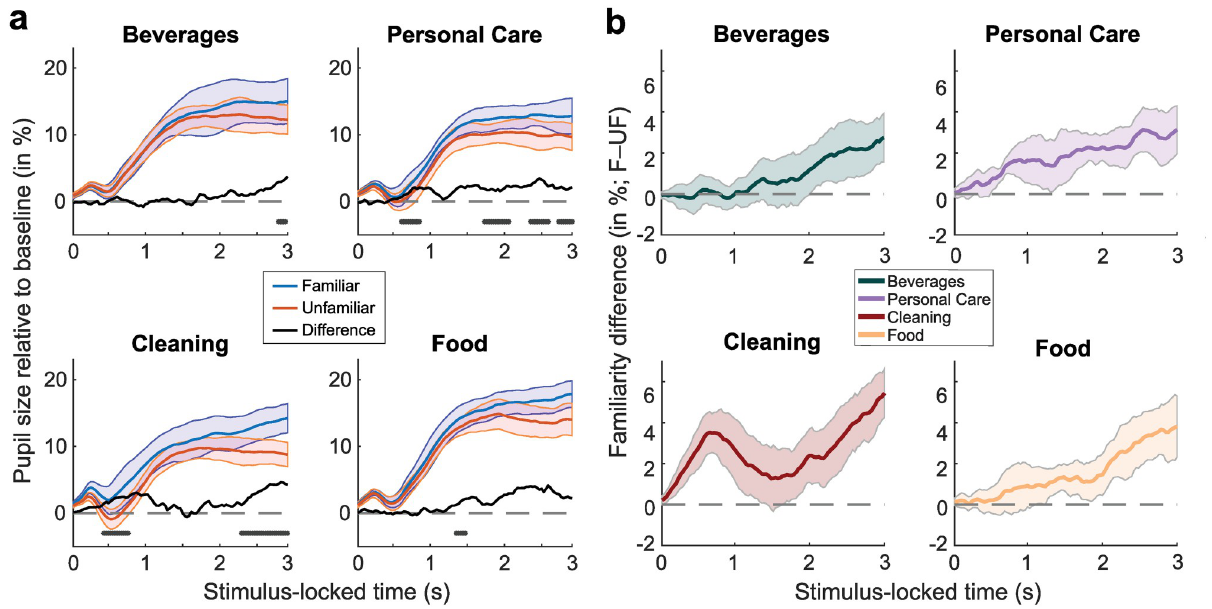
Fig 3. Product category-based pupil size change relative to baseline and individual dynamic range. a) Comparison of pupil responses to both familiar (blue) and unfamiliar (orange) intact branded images over time. Colorful lines show the group mean and shaded areas the bootstrapped standard errors of the mean for each condition. As a result of the temporal cluster-based bootstrapping procedure, the solid black line depicts the bootstrapped difference between the two familiarity conditions and black dots denote clusters of significant windows (for details, see Methods). Dashed grey line depicts the median baseline pupil size of the last 150 ms leading up to the viewing of the intact image. The light blue and orange patches represent the bootstrapped standard errors for their respective familiarity condition. b) Mean group difference between familiar and unfamiliar (familiar–unfamiliar) intact branded images in percent of the individual dynamic range for each of the four product categories: beverages (green), personal care (purple), cleaning (red), food (yellow). Shaded areas represent bootstrapped standard errors of the mean. Note, difference lines illustrate the effective difference and not the bootstrapped